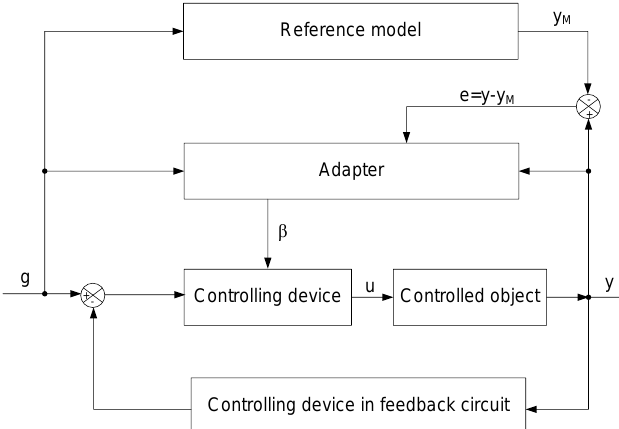
Fig. 5. Structural scheme of adaptive system with reference model.